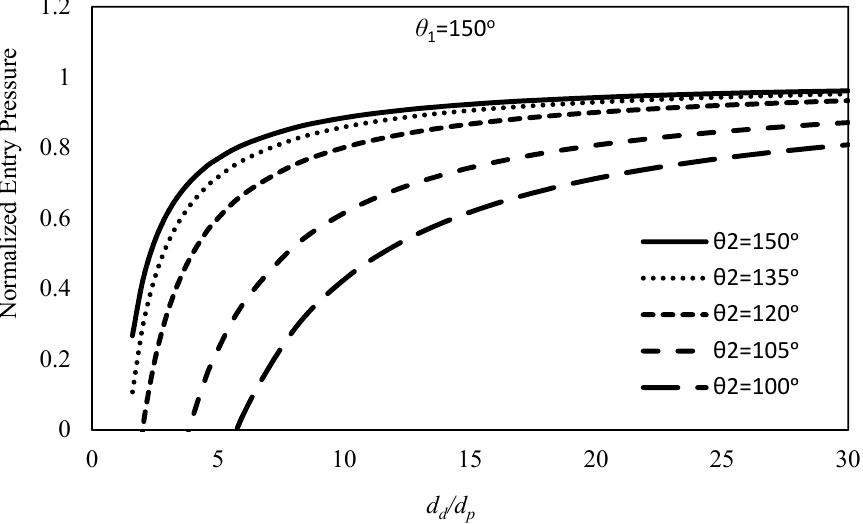
Figure A2. The entry pressure normalized relative to the capillary pressure at the pore entry (cid:0) (cid:1) (cid:3435)4𝜎 cos𝜃 (cid:2870) /𝑑 (cid:3043) (cid:3439) as plotted against the ratio of the droplet (𝑑 (cid:3031) ) versus the pore (𝑑 (cid:3043) ) diameters. From this graph, it can be seen that in general, when this ratio is smaller, the entry pressure is also smaller. The contact angle of the interface at the pore entrance has a significant effect, as shown on the